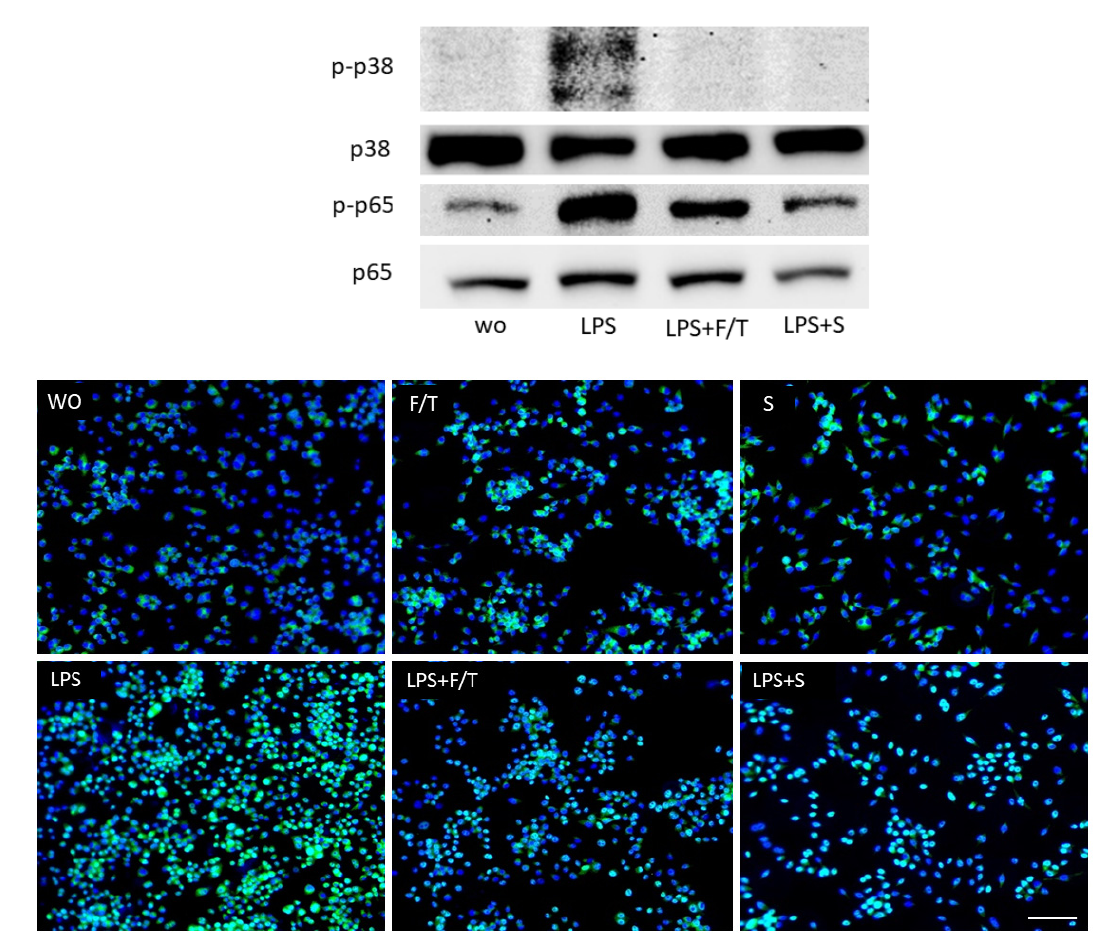
Figure 2. ST2 lysates reduce LPS-induced NF κ B and p38 signaling in RAW 264.7 cells. RAW 264.7 macrophages were exposed to ST2 lysates prepared by freeze/thawing (F/T) and sonication (S) with and without LPS, aiming to induce the phosphorylation and nuclear translocation of p65, together with phosphorylation of p38. Western blot analysis shows the chemiluminescence signals obtained with the phosphor-p65 and p65 and phosphor-p38 and p38 antibodies. Immunostaining revealed the green fluorescence signals obtained with the p65 antibody. Nuclear staining with DAPI appears blue. Scale bar indicates 100 µm and represents all pictures.